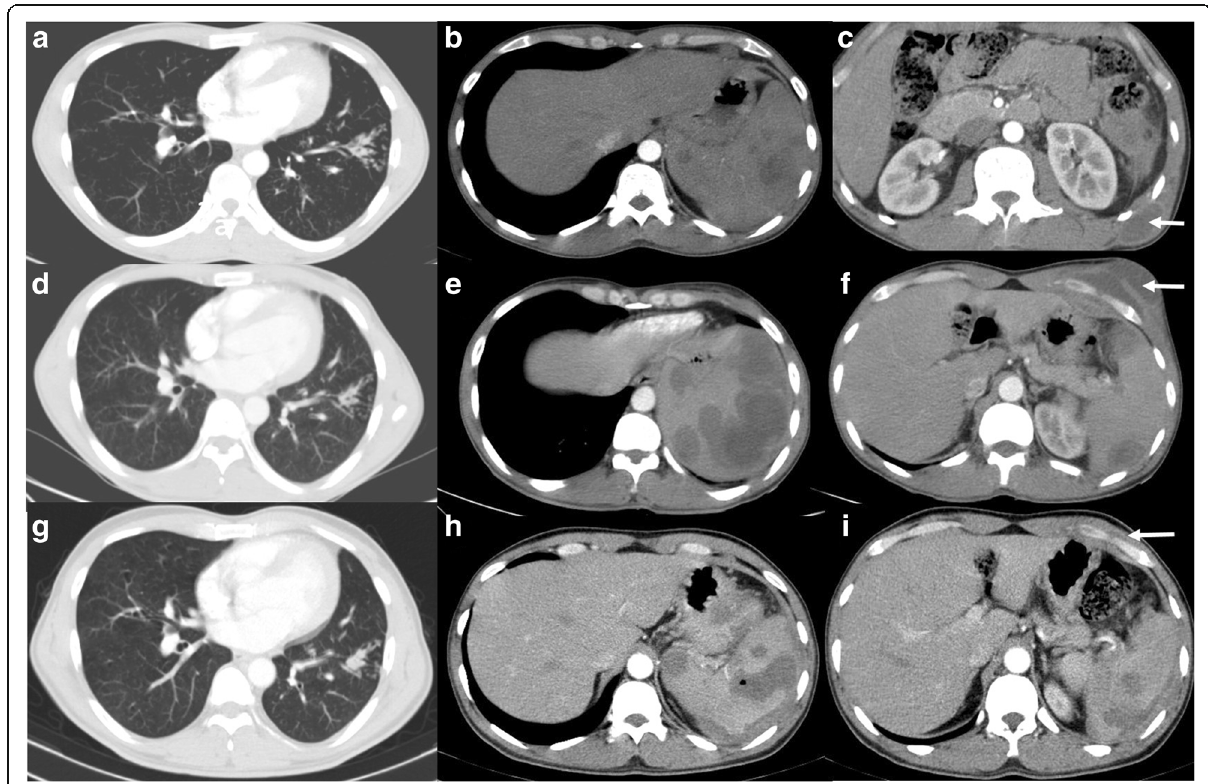
Fig. 2 Chronic melioidosis with TB. Forty-one-year-old gentleman, newly diagnosed to have diabetes mellitus, presented with respiratory symptoms, ( a ) CT thorax showed the tree in bud opacities in the left lower lobe. Upper abdomen sections reveal ( b ) multiple hypodense foci in the spleen suggestive of small abscesses and ( c ) a small abscess in the left posterior lower chest wall (arrow). Cytology from the chest wall showed necrotising granulomatous inflammation, and antituberculous treatment was started. Two years later, he presented with new onset of left anterior chest wall swelling, for which CT thorax and abdomen were performed which showed ( d ) mild reduction in the ‘ tree in bud ’ opacities, but ( e ) increase in the size and number of splenic abscesses and ( f ) interval development of the left anterior lower chest wall abscess (arrow). Pus culture from the chest wall grew Burkholderia pseudomallei . Follow-up CT after 6months showed, ( g ) stable tree in bud opacities in the lung, ( h ) near complete resolution of the chest wall abscess (arrow) but with the presence of perisplenic fluid with persisting splenic lesions ( h and i ), suggestive of contained